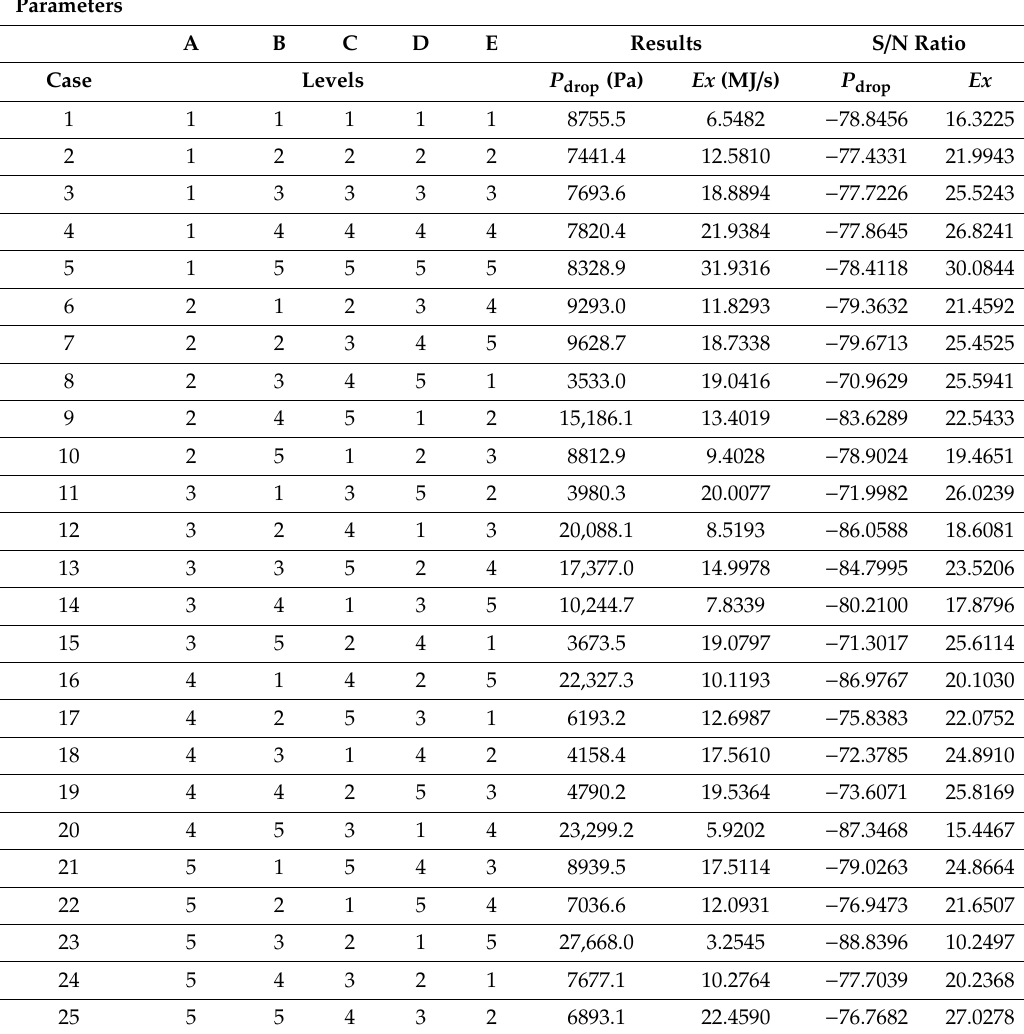
Table 7. P drop 1 and Ex 2 variation with their S / N ratios for the L 25 (5 5 ) orthogonal